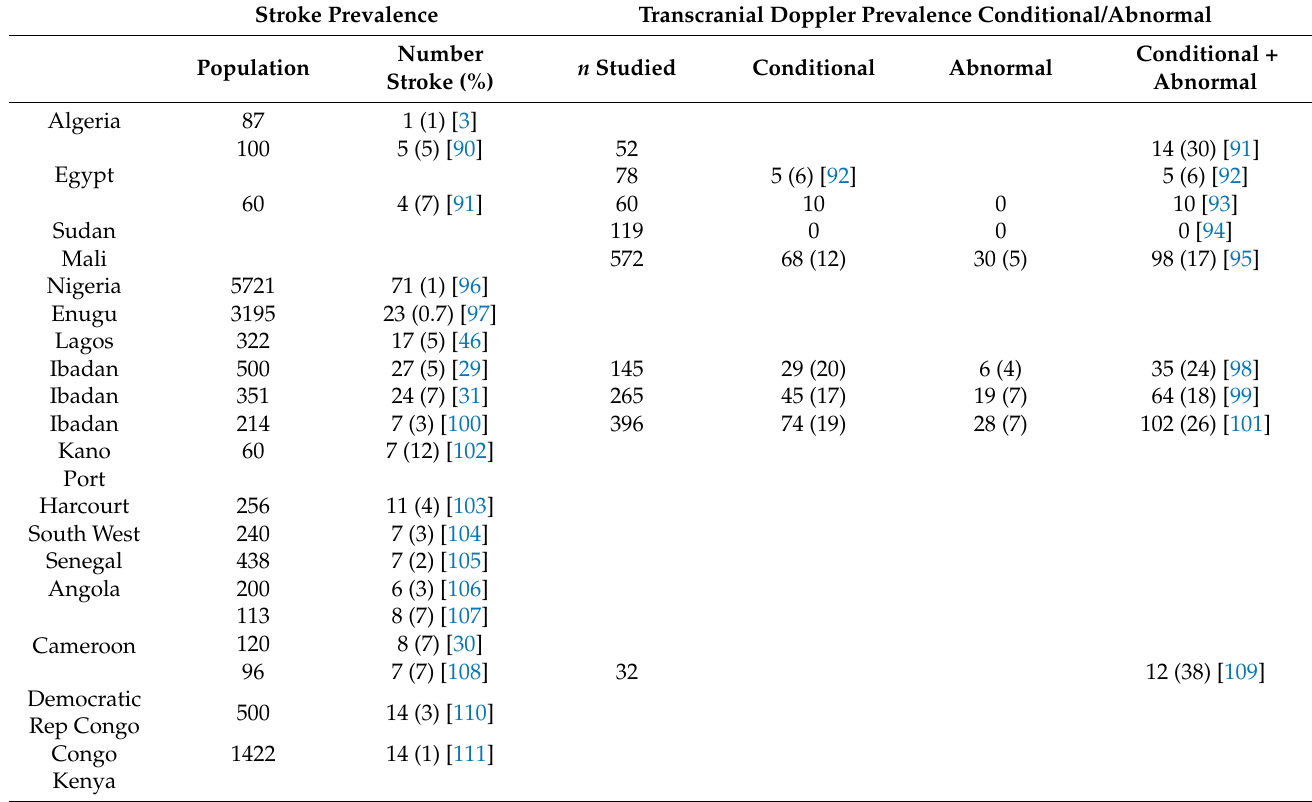
Table 1. Prevalence of Stroke and Conditional and Abnormal Transcranial Doppler in Africa. Stroke